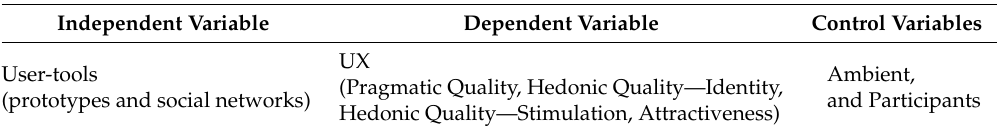
Table 2. Variables of our